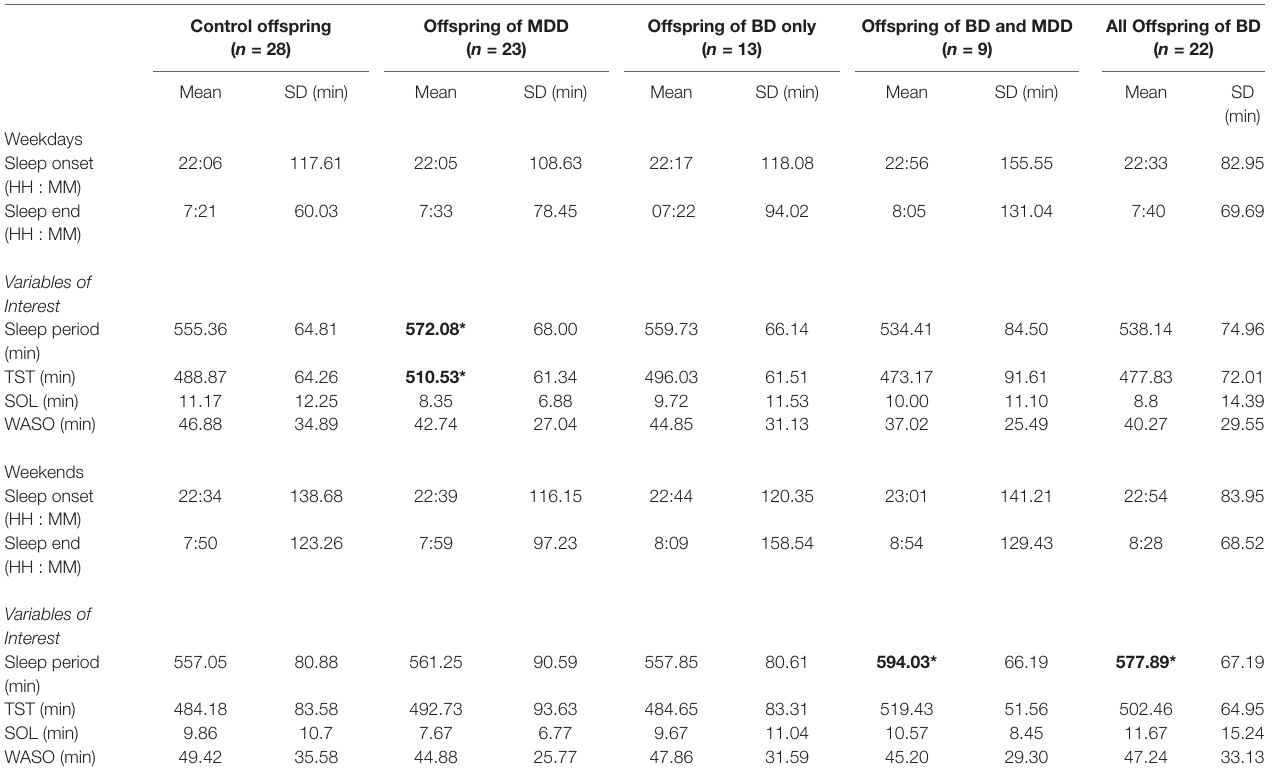
TABLE 3 | Sleep parameters derived from 14 days of actigraphy data by family history